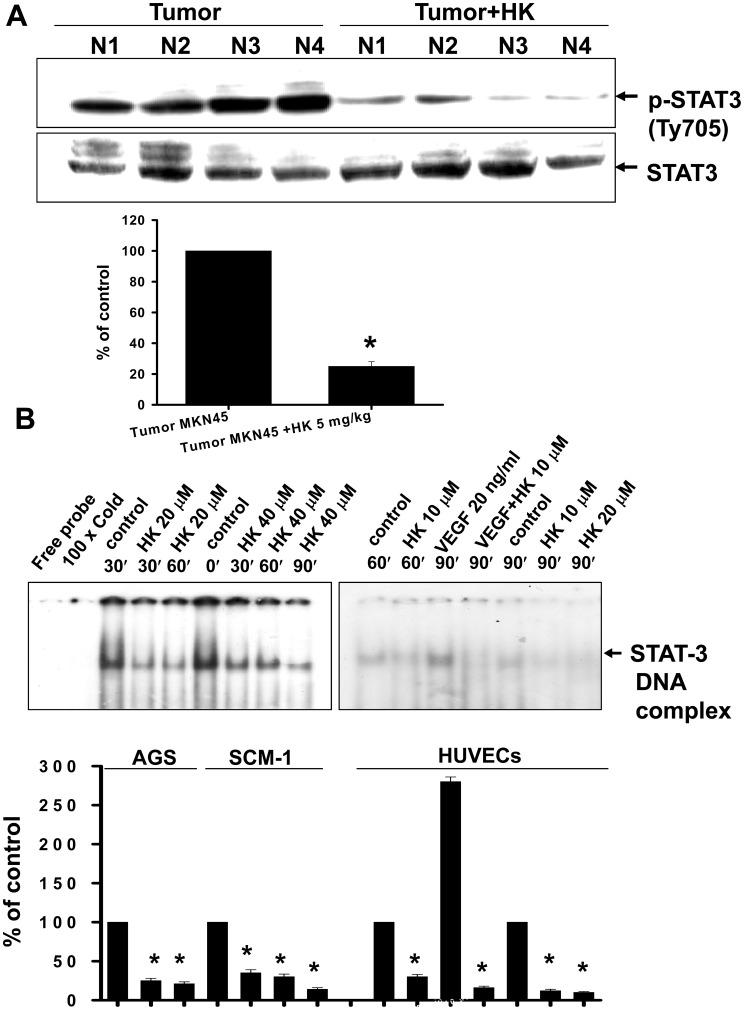
Effects of honokiol on p-STAT-3 expression in tumors and STAT-3 DNA binding activity in gastric cancer cells and HUVECs.(A) Western blotting for detection of p-STAT-3 (Tyr705) proteins in metastatic tumors isolated from mice with or without honokiol (HK) treatment is shown. (B) EMSA was performed for detection of STAT-3 DNA binding activity in AGS, SCM-1 (left panel), and HUVECs (right panel) with or without honokiol treatment. Cells were treated with honokiol for various time courses as indicated. VEGF (20 ng/ml) enhanced the STAT-3 DNA binding activity in HUVECs, and this enhancement was reversed by honokiol (10 µM). All data are presented as mean ± SEM of five independent experiments. *p<0.05 as compared with control.